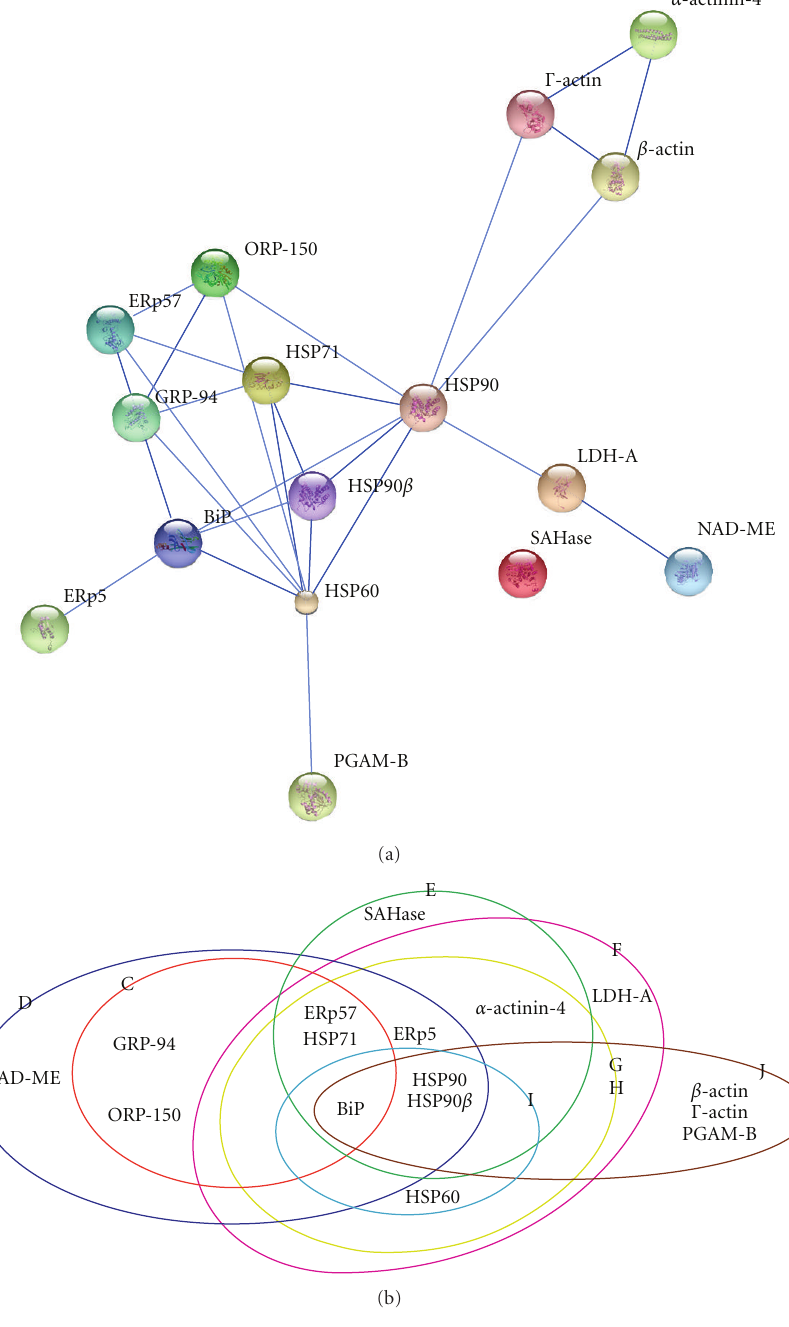
Figure 2: Interaction analysis of proteins from the HSP-associated complexes using the STRING database. The lines represent interactions and individual proteins are depicted as nodes. Stronger interactions are represented by thicker lines (a). The HSP-associated complexes from this study are shown in di ff erent ellipses. The sign of each protein complex is indicated on the edge of each ellipse